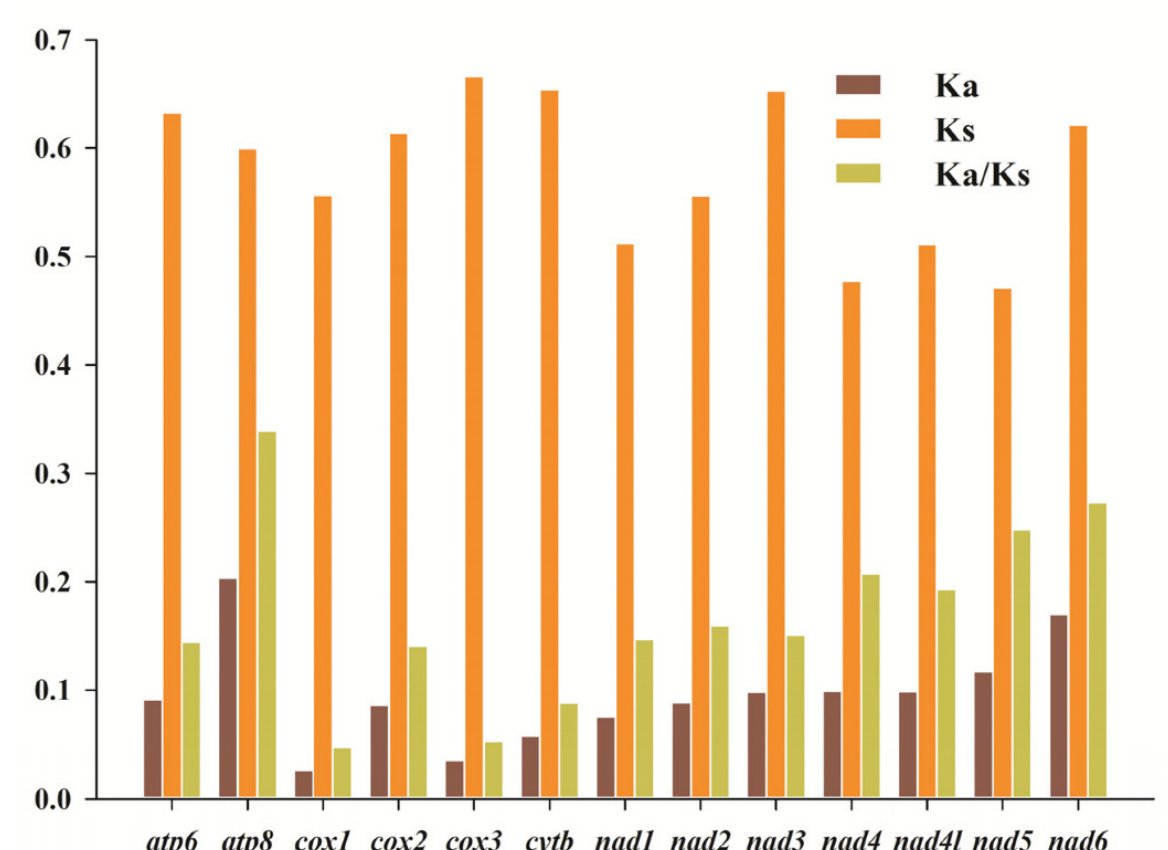
Figure 3. Evolution rate of mitochondrial protein-coding genes among five Prosopocoilus stag beetle species in the present study ( P. laterotarsus , P. castaneus , P. confucius , P. astacoides , and P. blanchardi ). Ka represents non-synonymous substitution rate, Ks represents synonymous substitution rate, and Ka/Ks represents the evolution rate of each PCG.